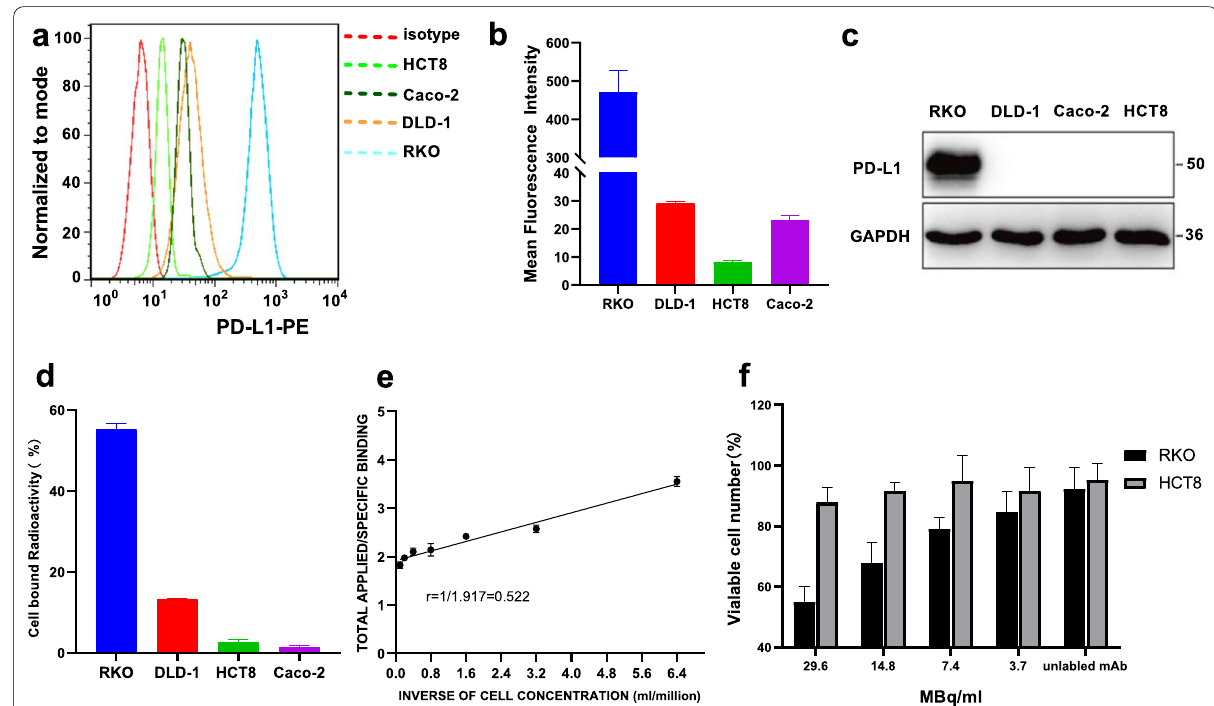
Fig. 1 Analysis of PD-L1 expression and cytotoxicity of 131 I-Atezolizumab on colorectal cancer cells. a Flow cytometry analysis of PD-L1 expression in different colorectal cancer cells (RKO, DLD-1, HCT8 and Caco-2). b FlowJo was used to conduct a quantitative analysis of mean fluorescence intensity. c PD-L1 (50 kDa) expression in cancer cells was analyzed using a western blot with GAPDH (36 kDa) serving as the internal control. d Cell binding assay of 131 I-Atezolizumab. e The immunoreactive fraction of 131 I-Atezolizumab and RKO cells. f Cytotoxicity of 131